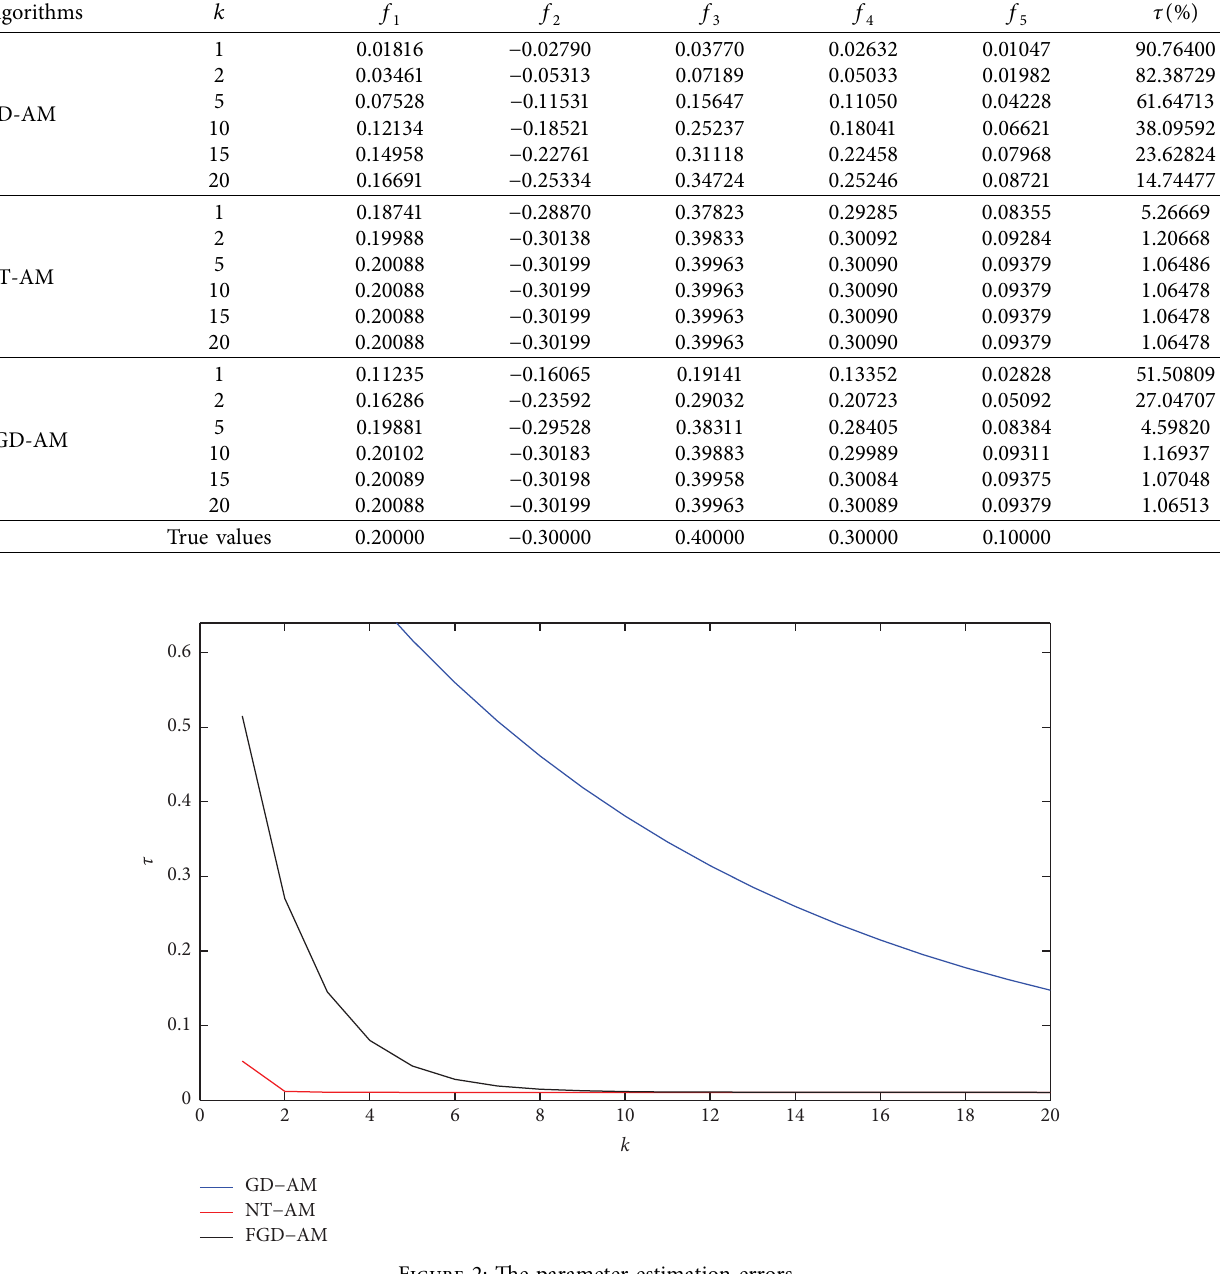
Table 1: Te parameter estimates and their estimation errors.